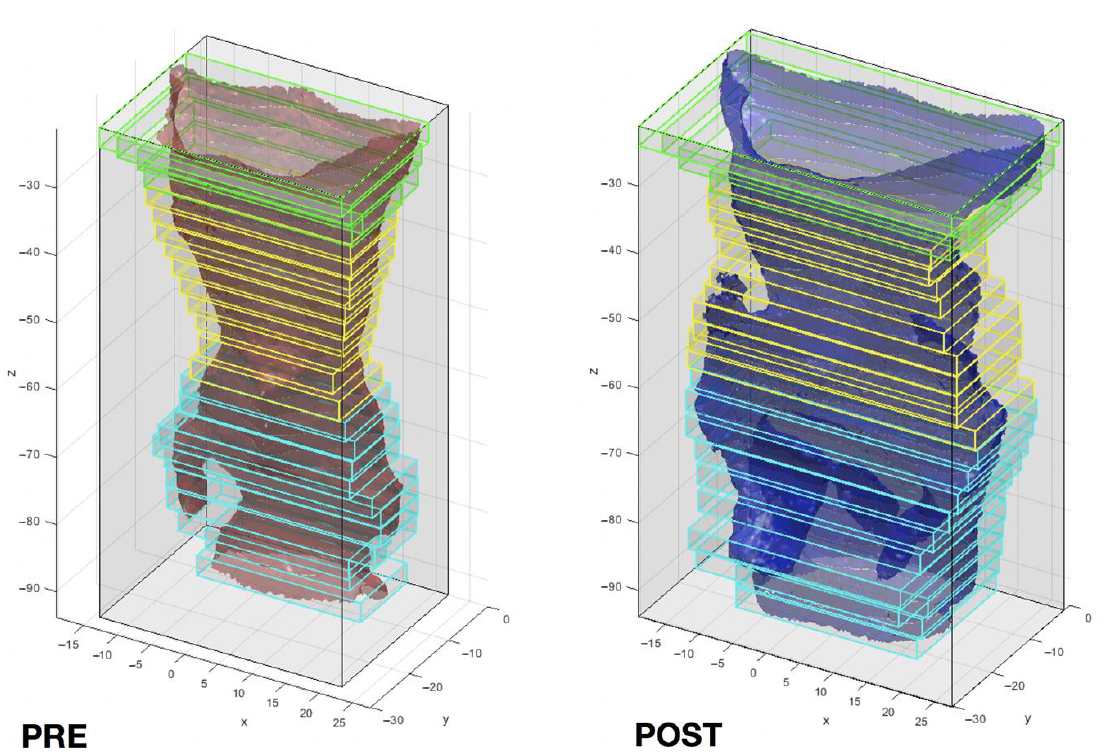
Figure 3. Upper airways 3D models evaluation and partitioning into bounding boxes in Matlab software. One single case is reported (left: pre-operative, right: post-operative).